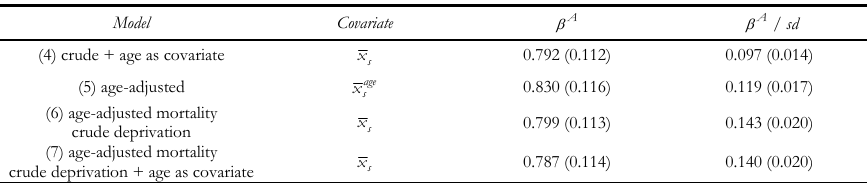
Tuscan Longitudinal Study. Regression coefficients (standard error) of census block average material